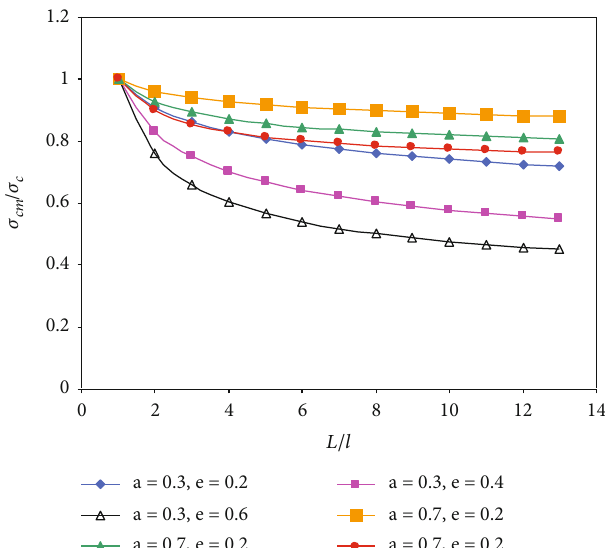
/ σ L / l for di ff erent a and e values. cm c with